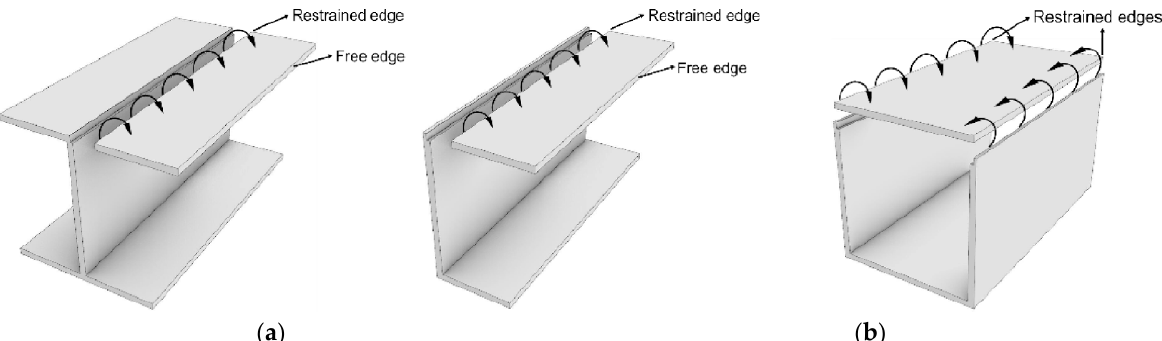
Figure 1. FRP composite profiles with ( a ) open-section and ( b ) closed-section (box) shapes (modified from [57]).